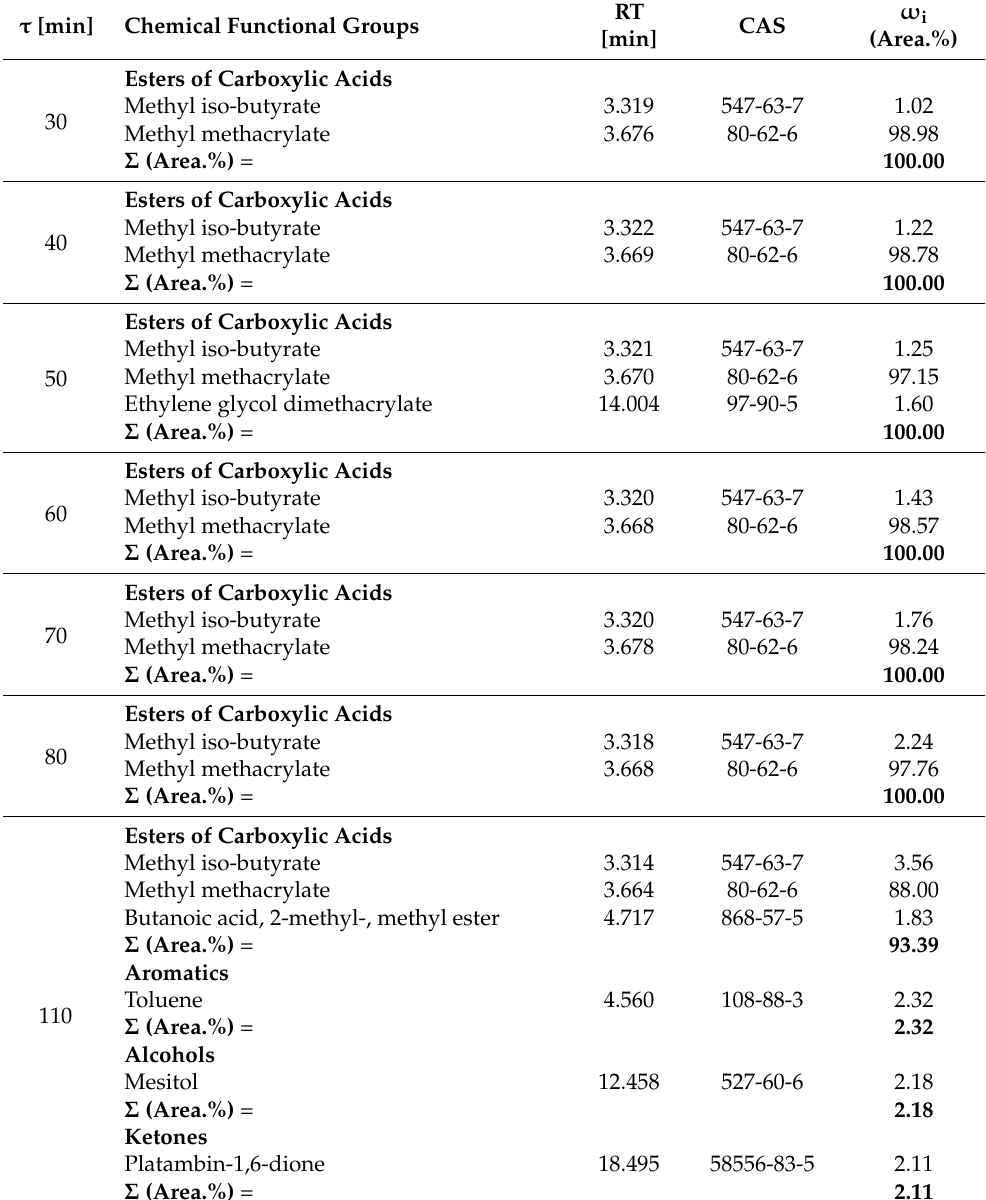
Table 6. Functional groups, sum of peak areas, chemistry registry numbers (CAS), and retention times of molecules identified by gas chromatography-mass spectrometry (GC-MS) in the liquid phase by depolymerization of PMMA based dental resins fragments/residues at 345 ◦ C, atmospheric pressure, and time interval of 30 to 110